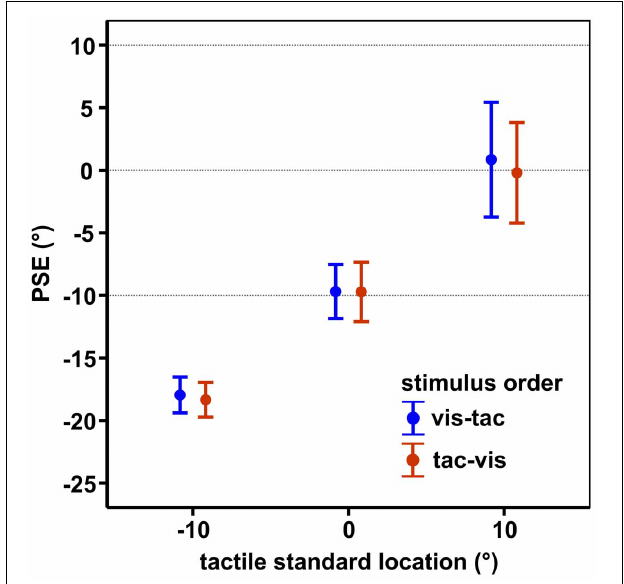
FIGURE 6 | Mean PSEs of the control condition, averaged across subjects for each standard location and stimulus order. Error bars display the standard errors of the mean. Horizontal dashed lines indicate the physical standard